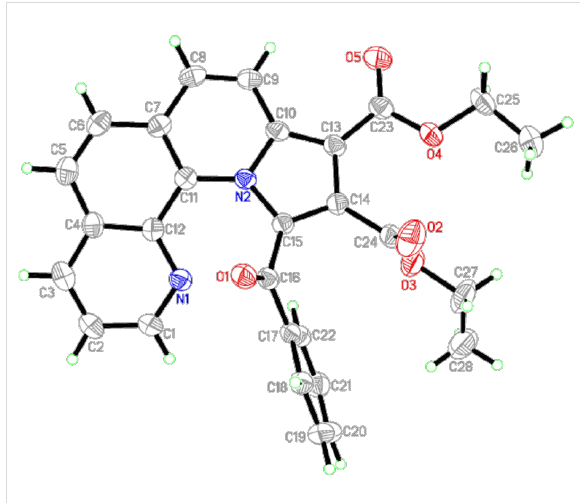
the compounds were performed on a Bruker KAPPA APEXII CCD diffractometer at 296(2) K. Structure solution by direct methods and refinements by full-matrix-least-squares methods on F 2 . Programs: APEX2 (Bruker AXS Inc., Madison, Wisconsin, USA) for data collection, SAINT (Bruker AXS Inc., Madison, Wisconsin, USA) for cell refinement and data reduc- tion, SHELXTL (Bruker AXS Inc., Madison, Wisconsin, USA) for structure determination, refinements and molecular graphics calculations. CCDC Numbers: 937560 (for compound 10a ) and 937561 (for compound 14e ) contain the supplementary crystal- lographic data for this paper. These data can be obtained free of charge from The Cambridge Crystallographic Data Centre via http://www.ccdc.cam.ac.uk/data_request/cif (or from